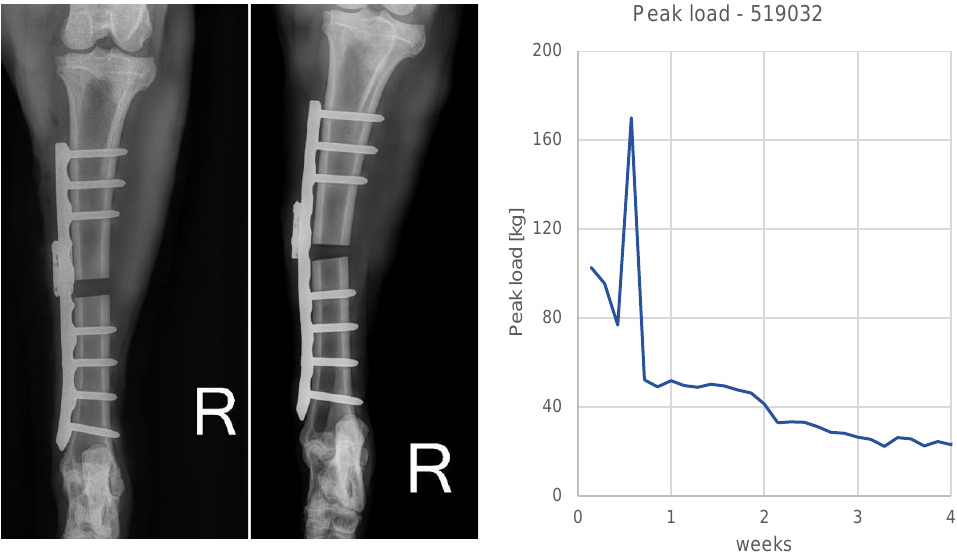
Figure 8. Plate bending in animal 519032. ( Left ): Post-op and 1-week AP radiographs. Plastic deformation of the plate after 1 week becomes apparent. ( Right ): calibrated daily peak load sensor data of the first 4 weeks. A spike (170 kg) at day 4 is visible.